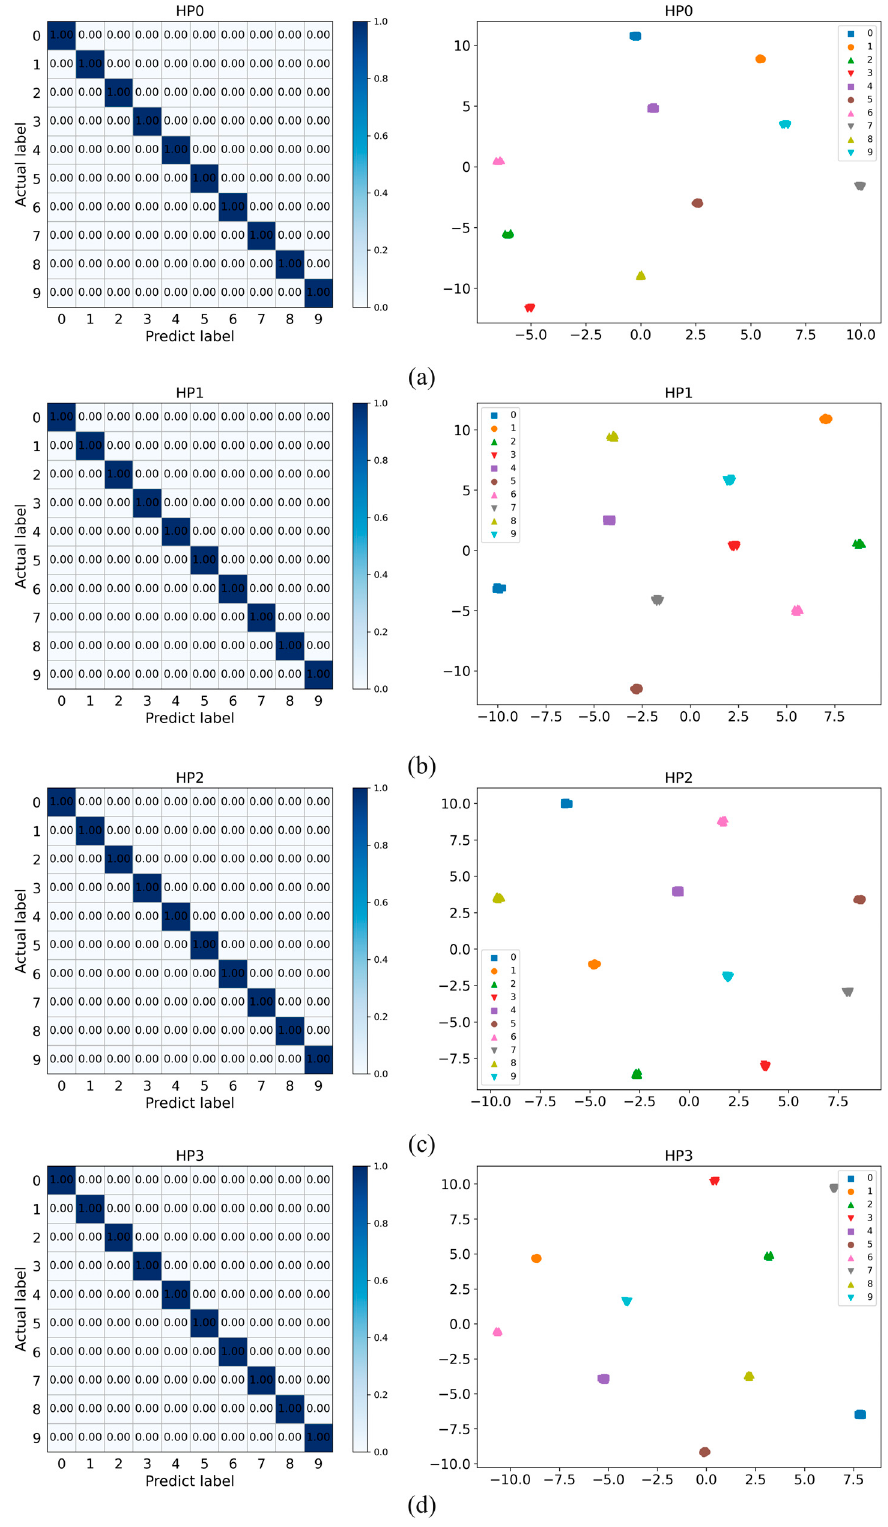
Figure 17. Confusion matrix and cluster analysis results of four load conditions: ( a ) HP 0, ( b ) HP 1, ( c ) HP 2, ( d ) HP 3.